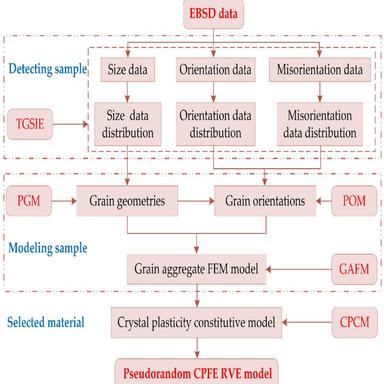
Flow chart of the proposed pseudorandom based CPFE modeling method (TGSIE means true grain scale information extraction, PGM means pseudorandom geometry method, POM means pseudorandom orientation method, GAFM means grain aggregate FEM modeling, CPCM means crystal plasticity constitutive modeling).